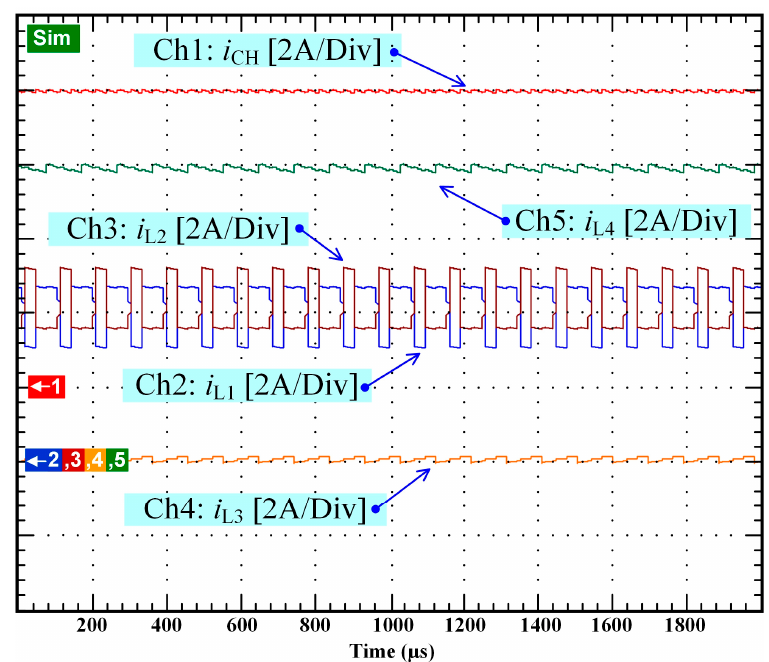
Figure 9. Simulation results: TLIBC performance with compensation and re-phase technique.